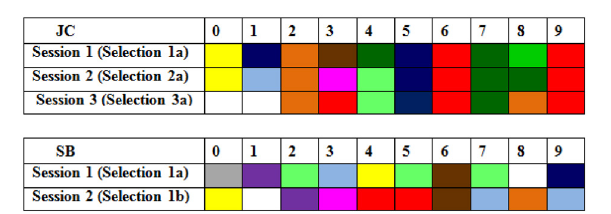
FIGURE 1 | Color choices in the first presentation of digits (0–9) in Sessions 1–3 for synesthete JC (i.e., over 4 years) and those from an aged matched control SB (over 10 s; in Session